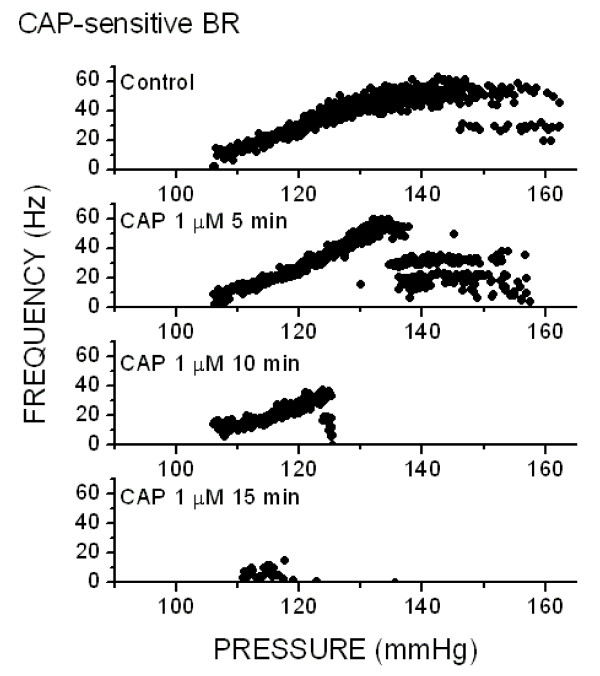
Capsaicin-sensitive baroreceptor. Capsaicin (1 μM) depressed the pressure-discharge response of an irregular aortic BR. The discharge properties including high coefficient of variation (COV = 9.9) of discharge, low discharge rate (maximum of 40 Hz) and low slope-sensitivity – all characteristic of C-fiber BRs. Pressure was ramped from 40 – 160 mmHg at a rate of 1 mmHg/sec. CAP progressively interrupted discharge with intermittent drops in discharge rates to half or less the prevailing rate (points at high pressures falling below the general trend). At 10 min and beyond, the BR failed to respond to suprathreshold pressures and at 15 min the relation was completely blocked. The loss of individual instantaneous frequency points by discrete increments (integer reciprocals, e.g ½. 1/3, etc.) indicates likely conduction block.